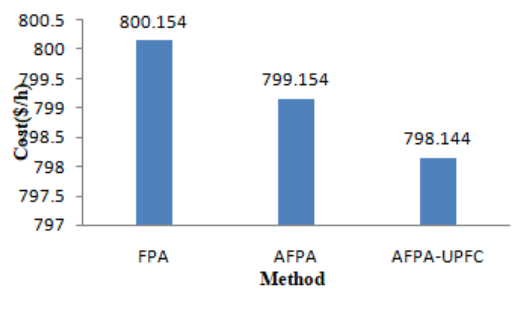
Figure 3. Fuel cost for different OPF techniques